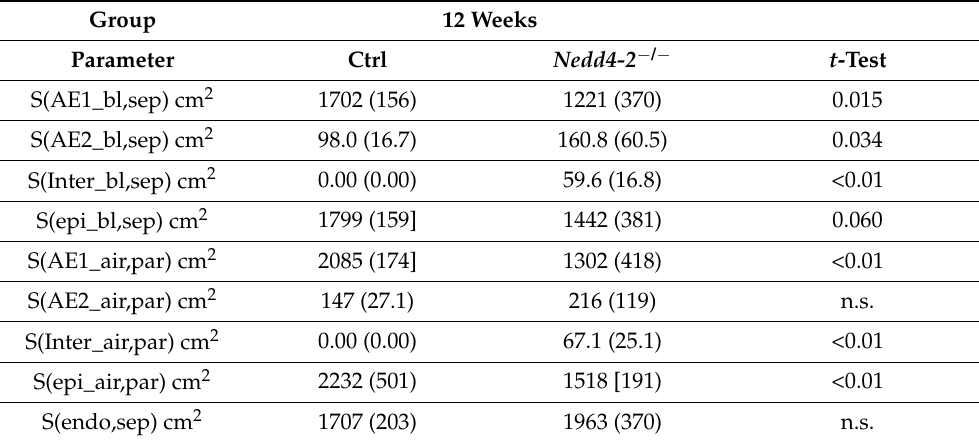
Table 3. Surface areas of epithelial cells after 12